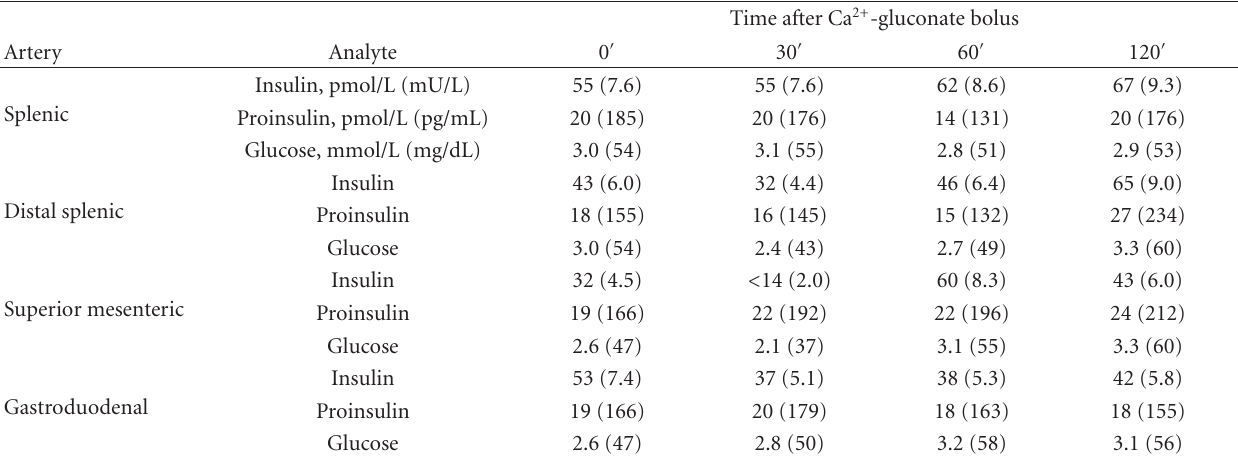
Table 2: Results of the venous sampling during selective angiography (Imamura test). Normal range for insulin concentration was 43– 210pmol/L (6.0–29.1 mU/L) and for proinsulin concentration was < 1.1pmol/L